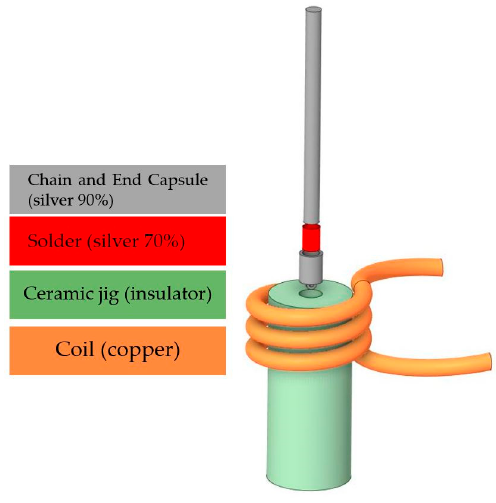
Figure 8. A simplified solid model.